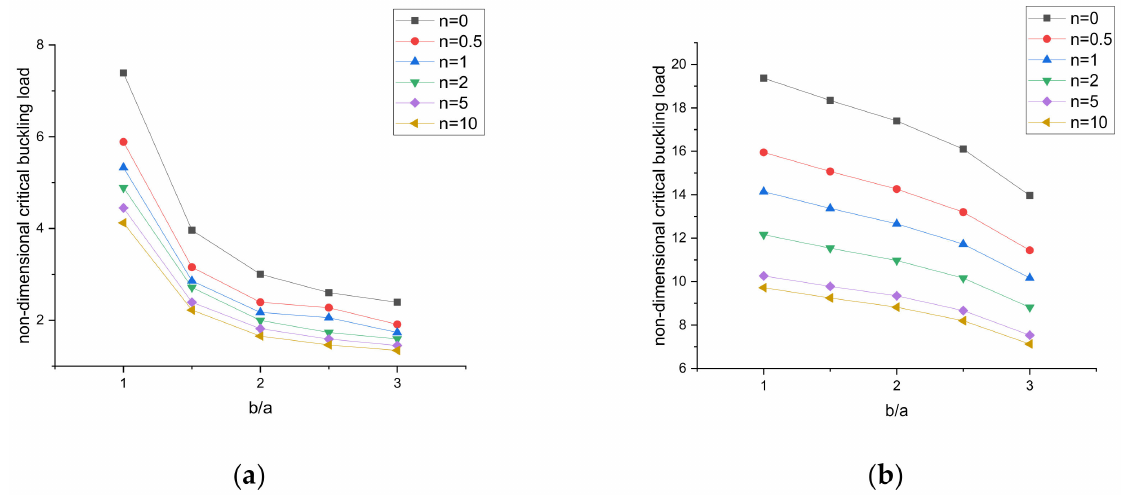
Figure 10. Variation in the buckling load under uniaxial compression. ( a ) SSSS, ( b ) CCCC.